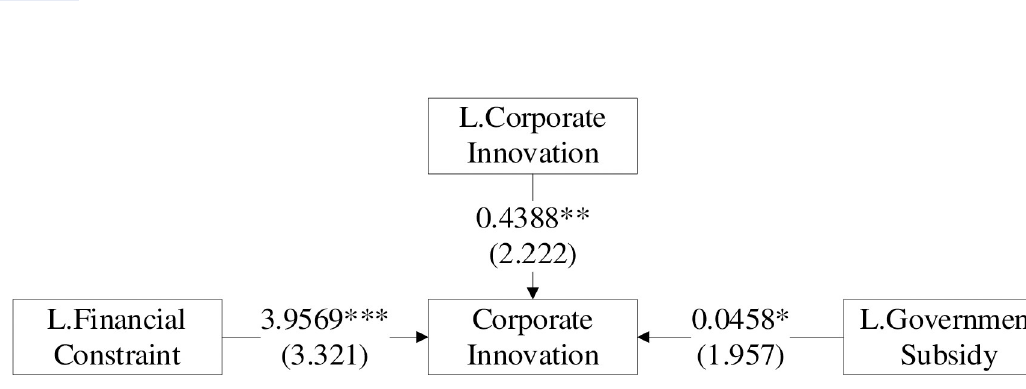
Fig 4. Main results of model (4) in Table 10. [1] t statistics in parentheses. [2] � , p < 0.1; �� , p < 0.05; ��� , p <